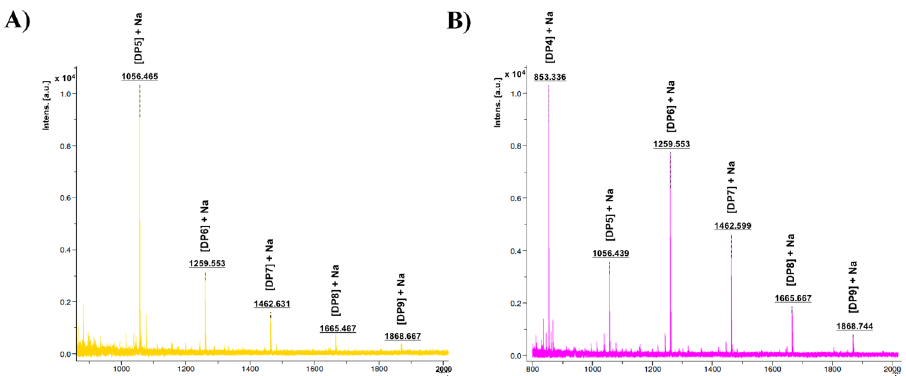
Figure 6. MALDI-TOF MS analysis of CHOS/TG products with DP5 and DP6 substrates catalyzed by Ec Chi1. The each 40 μ L of reaction sample was concentrated under reduced pressure at 25 °C and dissolved in 10 μ L of MilliQ H 2 O. The 2 μ L of the reaction mixture was mixed with equal volume of 2,5-dihydroxybenzoic acid (2,5- DHB), and the resultant solution was subjected to mass measurements using an Ultraflex MALDI – TOF/TOF instrument. The masses shown here are with Na